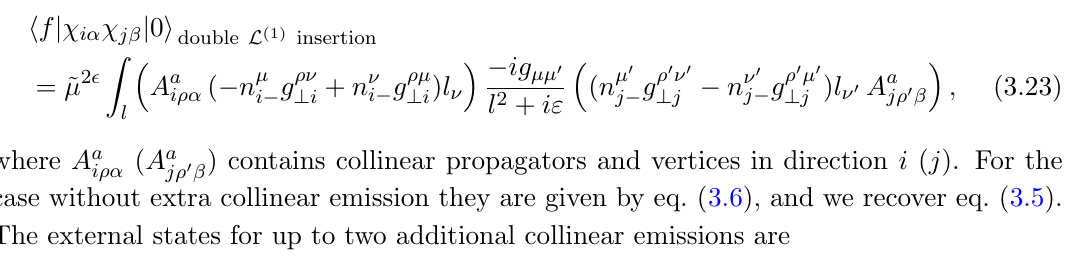
Figure 3 . Generic soft one-loop diagram featuring a double insertion of directions i and j , respectively. Solid lines without arrow can be either collinear quarks or gluons. Dashed lines illustrate possible sub-diagrams with additional collinear emissions (additional emis- sions directly o(cid:11) the current are not shown). In the second line, we show possible sub-diagrams. Only diagrams that contain at most two dotted lines, i.e. two collinear emissions, need to be